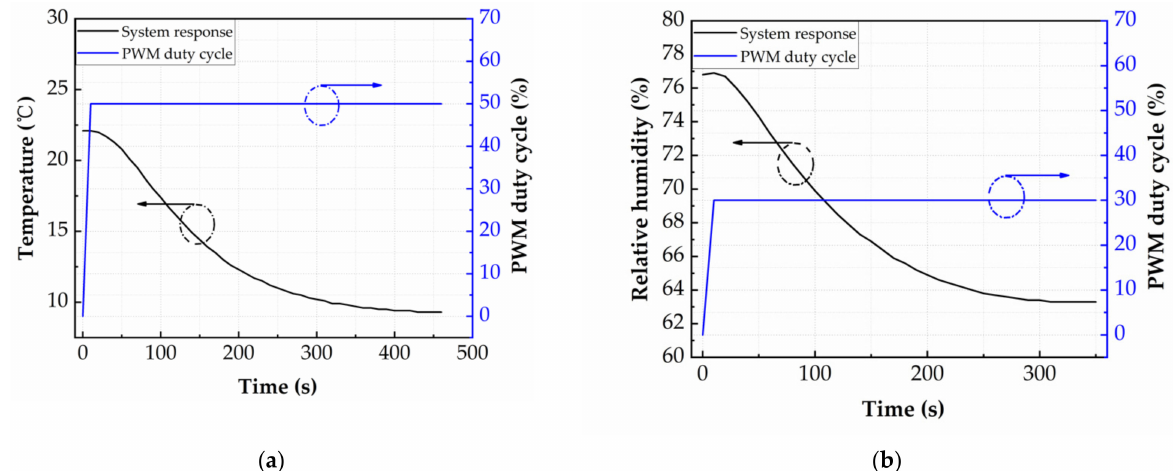
Figure 7. ( a ) Temperature response of the test system to a 50% PWM duty-cycle step cooling signal. ( b ) Relative humidity response of the test system to a 30% PWM duty-cycle step cooling signal.